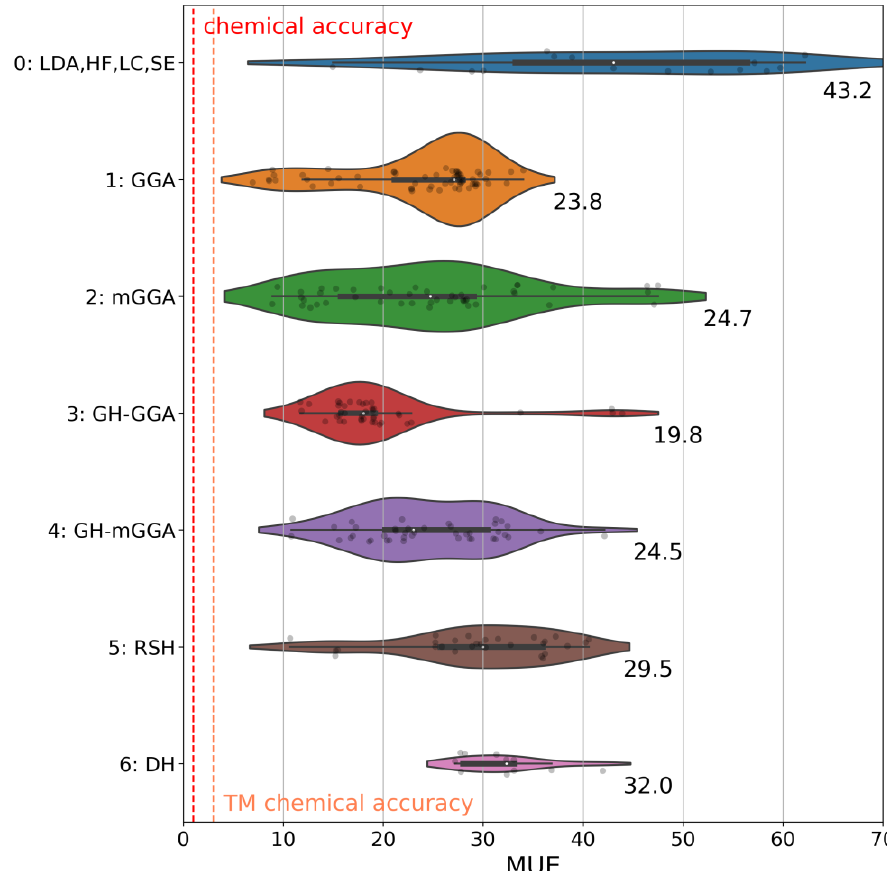
Figure 1. Distribution of the mean unsigned error (MUE) for the Por21 database for electronic structure methods divided into seven groups based on their ingredients (see text). Each group’s average MUEs is reported at the bottom-right of each violin. The area of each violin is proportional to the number of functionals in each group. The white dot in the center of the plot shows the median of the distribution. The thicker horizontal bar inside a violin shows the interquartile range of the data. The thinner black bar inside a violin shows 1.5 times the interquartile range of the data. Individual MUEs are also reported as black points within each violin (smoothness was applied; hence some outliers exist). Chemical accuracy and transition metal (TM) chemical accuracy ( vide infra ) are also reported (in red/orange, respectively, vertical dashed lines). All values in this plot are in kcal/mol.